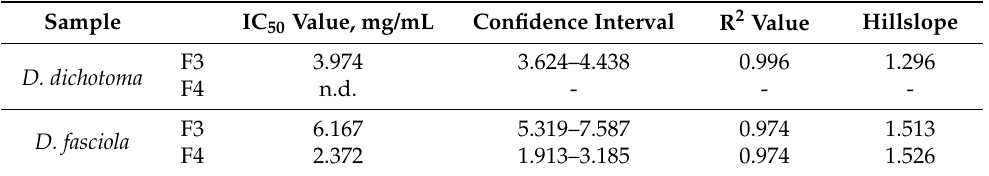
Table 6. Calculated half-maximal inhibitory concentrations (IC 50 ) with the presented confidence intervals, R 2, and Hillslope values obtained using the ABTS assay ( n = 3). Sample IC 50 Value, mg/mL Confidence Interval R 2 Value